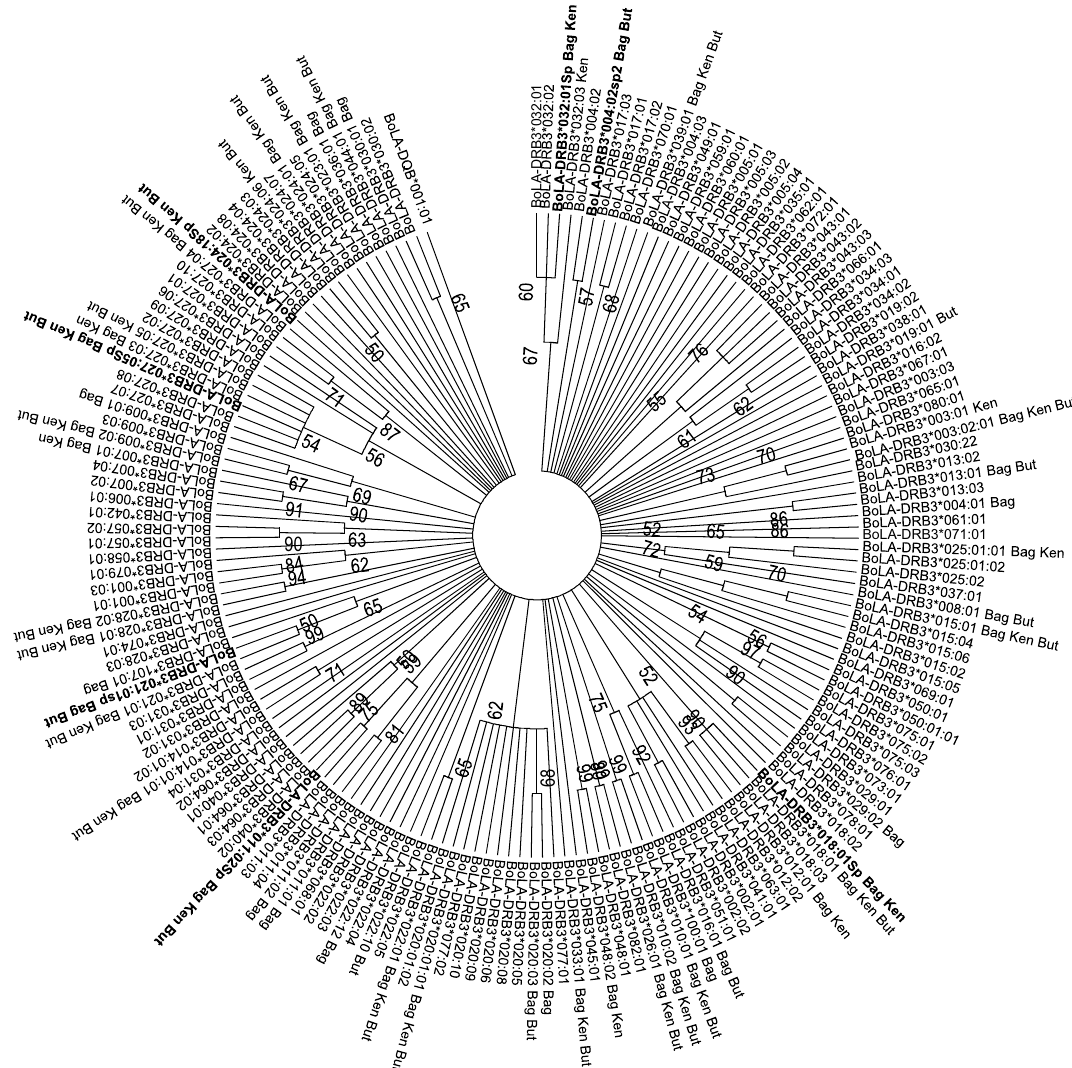
Figure 3. Neighbor-joining (NJ) tree constructed from the 270 bp nucleotide sequence that includes the β1 domain encoded by all reported BoLA-DRB3 alleles and the seven new ones ( BoLA-DRB3*004:02Sp2, BoLA- DRB3*011:02Sp , BoLA-DRB3*018:01Sp , BoLA-DRB3*021:01sp , BoLA-DRB3*024:18Sp , BoLA-DRB3*027:05sp , and BoLA-DRB3*032:01sp ). Numbers are bootstrap percentages that support each node. Bootstrapping was carried up with 1000 replicates to access the reliability of individual branches. Bag = Baggara, But = Butana, Ken = Kenana. Arrows indicate novel alleles.